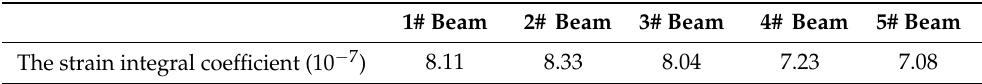
Table 4. The mid-span strain integral coefficient of each beam bottom.